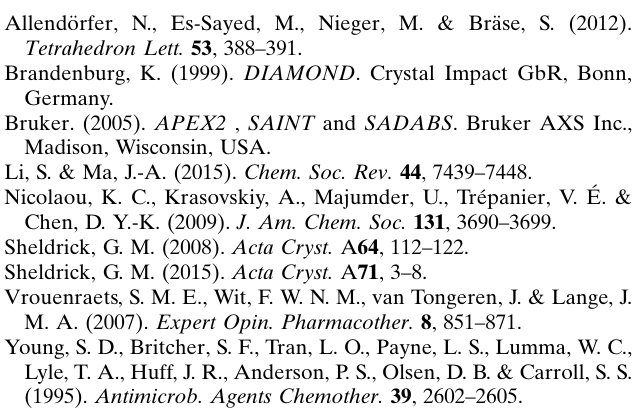
(cid:5) z ; (ii) (cid:5) x , (cid:5) 1 + y , 3 2 2